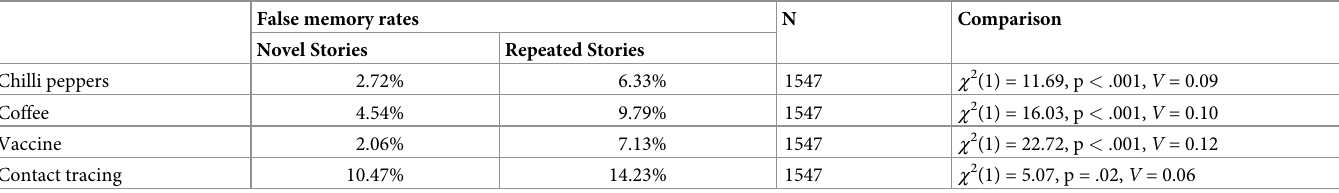
Table 1. Percentage of participants who reported a false memory at follow-up for novel and repeated stories.